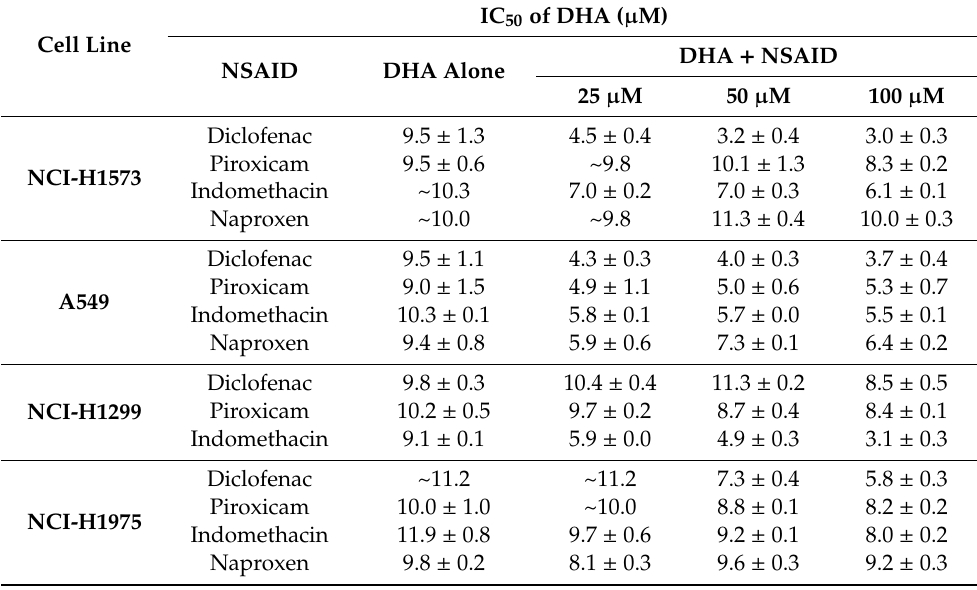
Table 1. IC 50 of DHA alone and co-treatment with non-steroidal anti-inflammatory drugs (25, 50